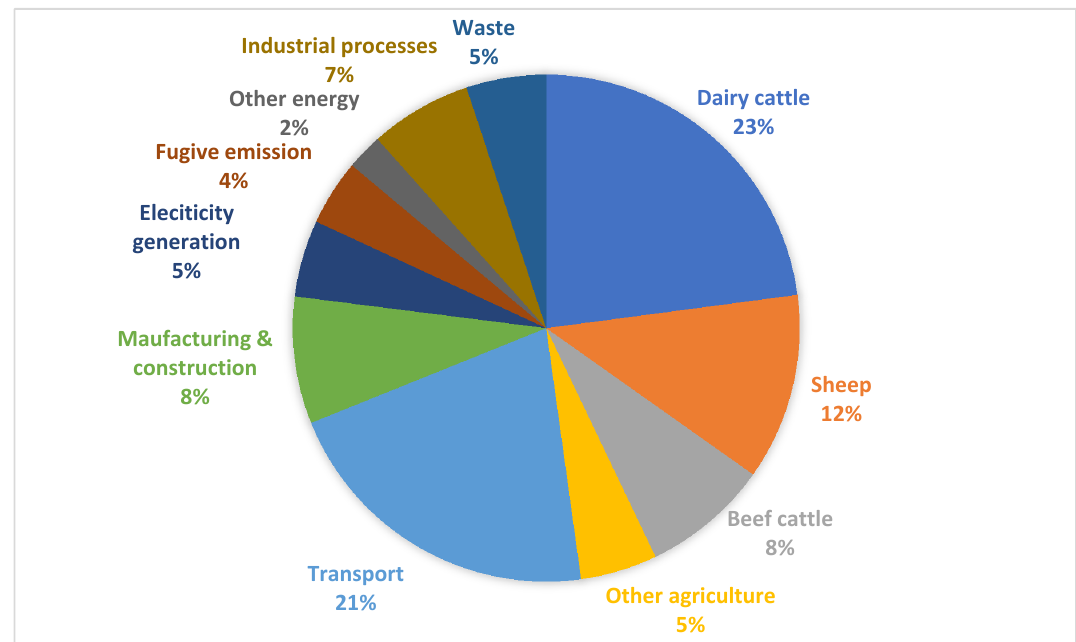
Figure 3. Breakdown of contributing sources of greenhouse gas (GHG) emissions in NZ (This work uses material sourced from the Ministry for the Environment, Stats NZ, and data providers, which is licensed by the Ministry for the Environment and Stats NZ for re-use under the Creative Commons Attribution 3.0 New Zealand licence.